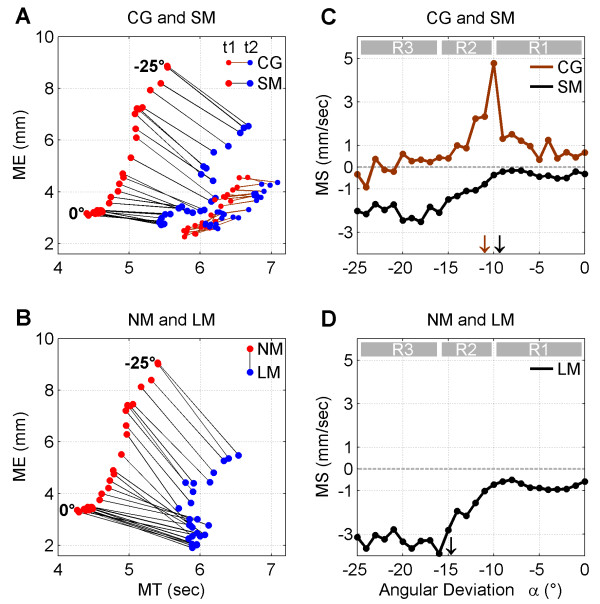
Movement slope (MS). A) Comparison of adjusted means of ME and MT at each angular deviation α for both measurement points (t1 and t2) and both groups (CG and SM). For each α value, data points for t1 and t2 are connected by a black line within each group SM and CG. B) Comparison of ME and MT at each angular deviation α for both groups NM and LM. Data points for each α value are connected by a black line between the two groups NM and LM. In A) and B), the dependence of MS with α can be visually estimated by the change of steepness or slope across the lines. The pairs (MT, ME) for times t1 and t2 and groups LM and NM are denoted by blue and red colors respectively. C) Dependence of MS with α for both CG (brown) and SM (black) groups. Downward arrows indicate the adjusted mean of angular threshold at time t2 for both groups (similar color coding). D) Dependence of MS with α for the comparison NM & LM. The downward black arrow indicates the adjusted mean of angular threshold for the LM group. The three α-ranges R1, R2, and R3 are represented in gray.